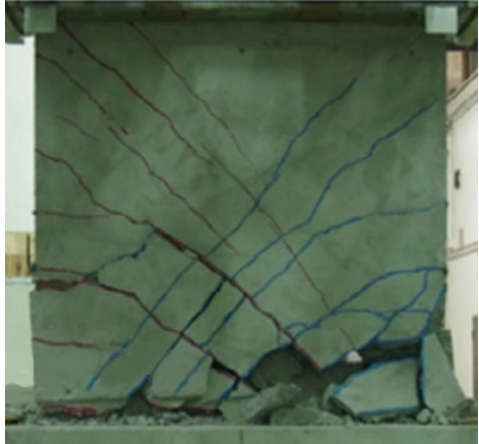
Figure 7. Damage modes of RC shear walls [12]. Copyright 2017, Engineering Structures.